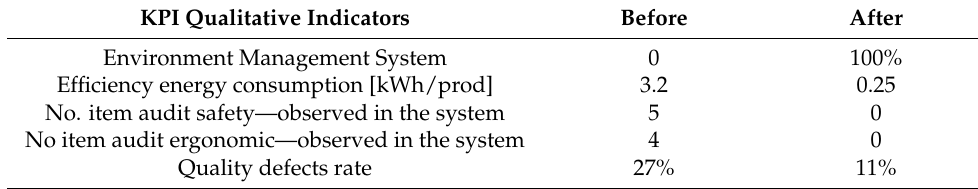
Table 3. Qualitative indicators